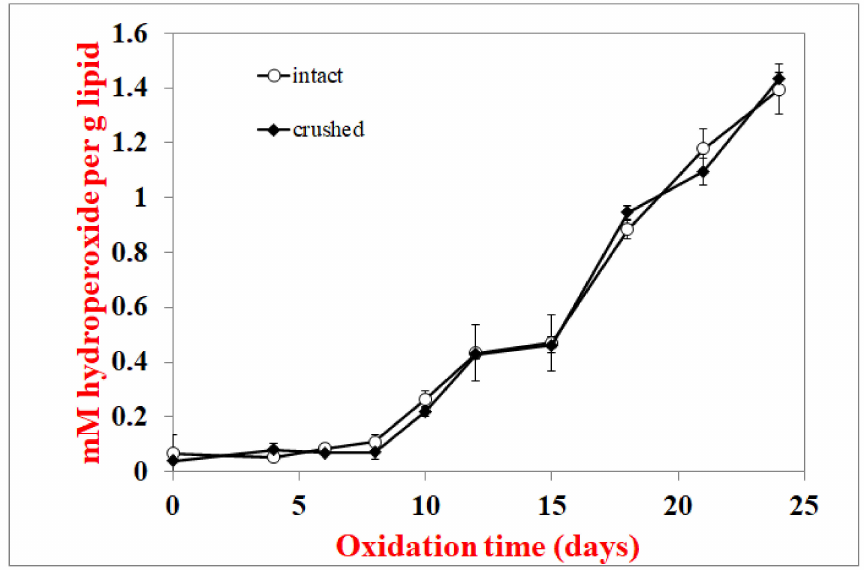
Figure 3. Lipid hydroperoxide formation at 55 ◦ C in crushed and whole crackers. Data points are the average of 3 measurements ± standard deviations.